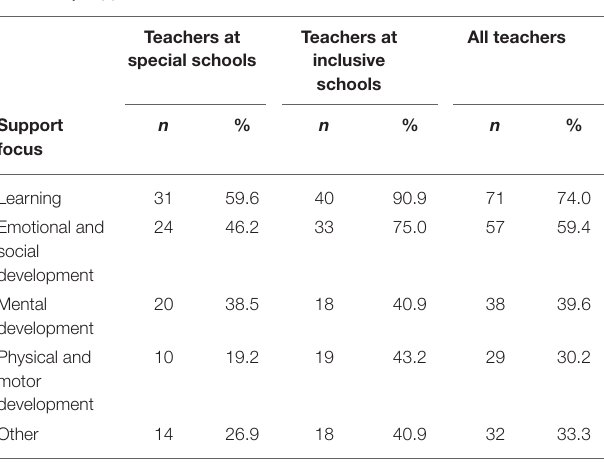
TABLE 4 | Support